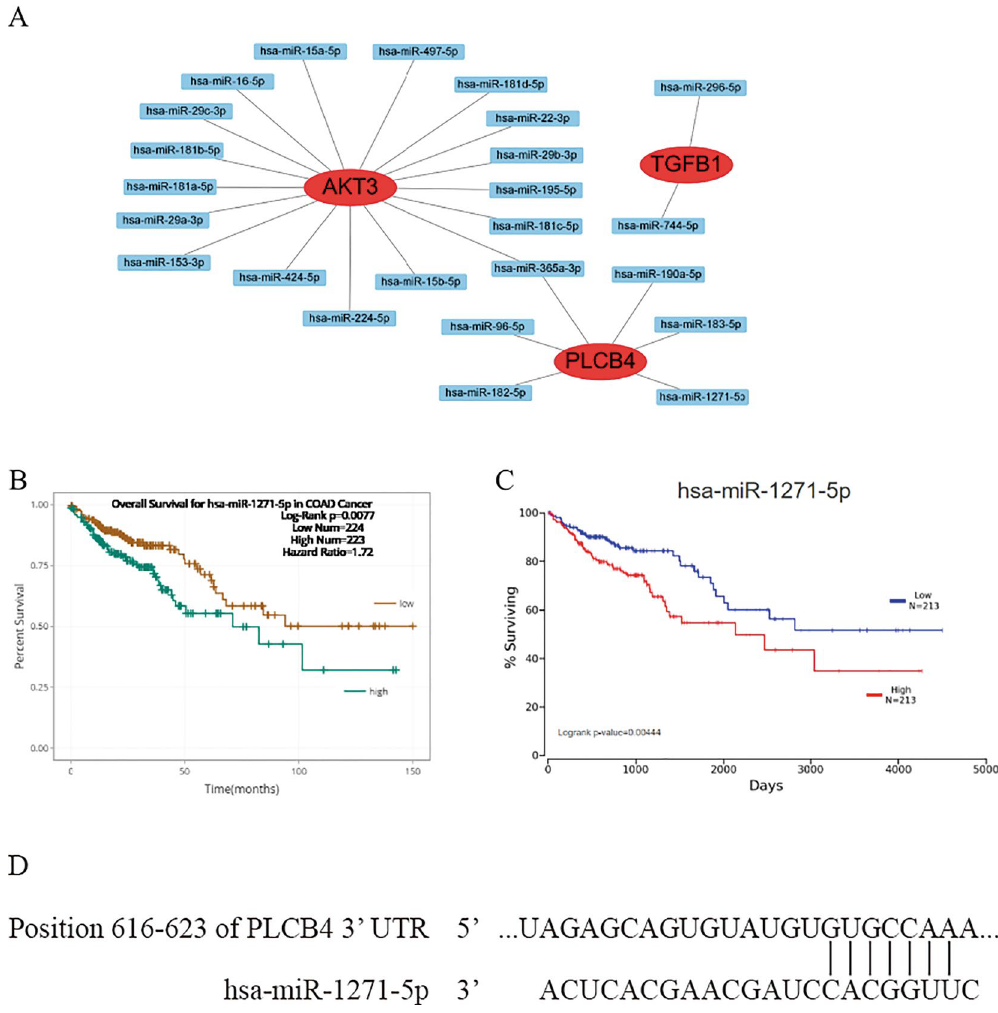
ENCORI and ( C ) OncoLnc database. ( D ) The binding sequence between hsa-miR-1271-5p and PLCB4